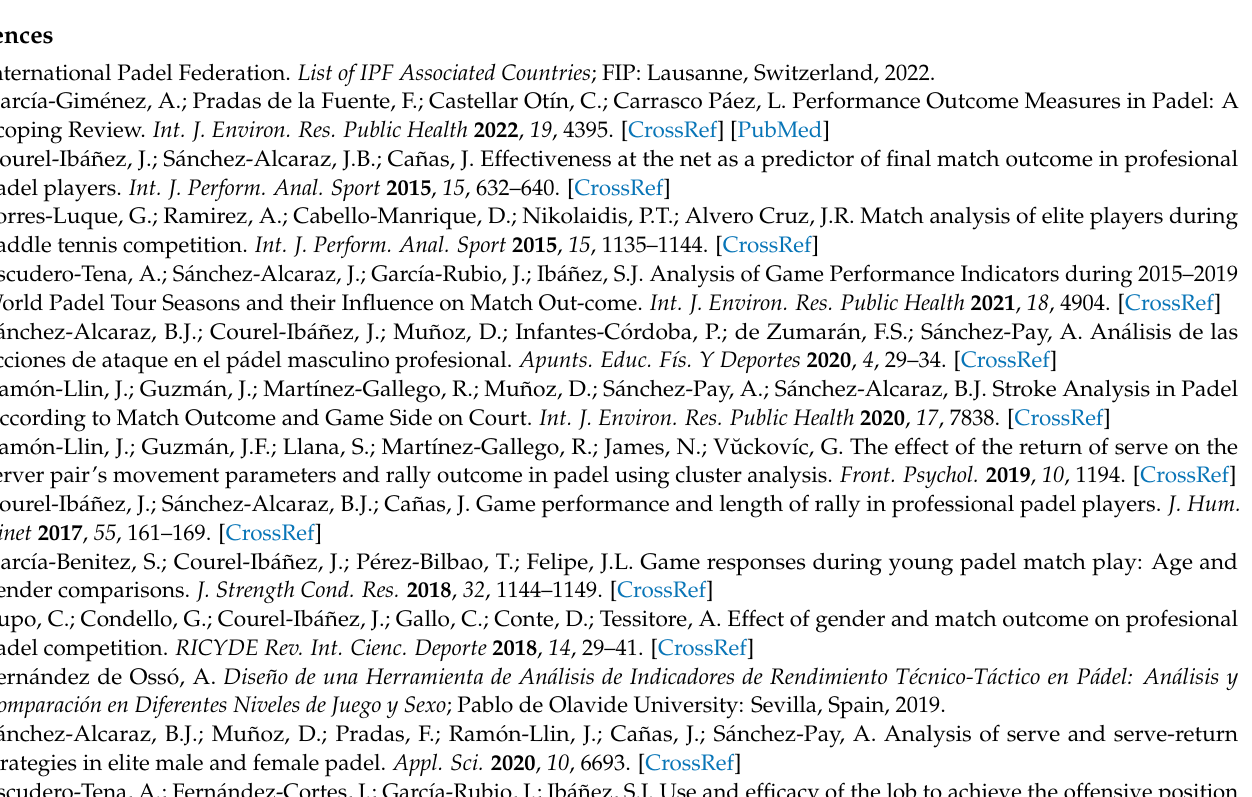
Table S1: Links to each video; Table S2: Analyzed